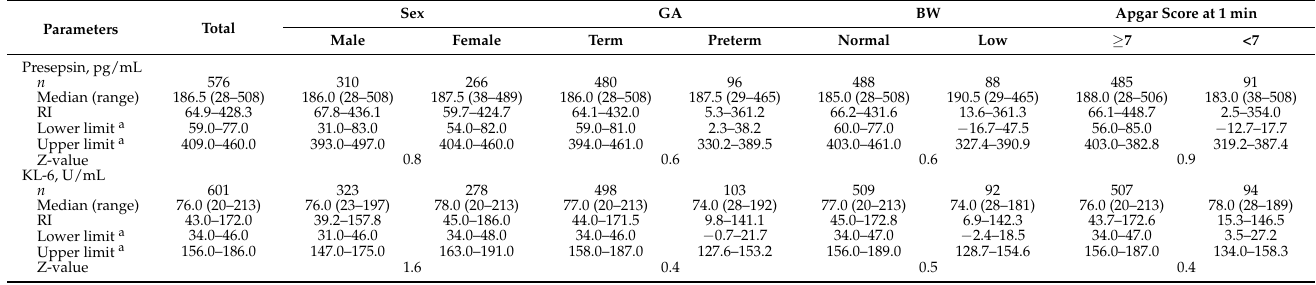
Table 2. Reference intervals of the total group for presepsin, KL-6, and SP-A according to neonatal